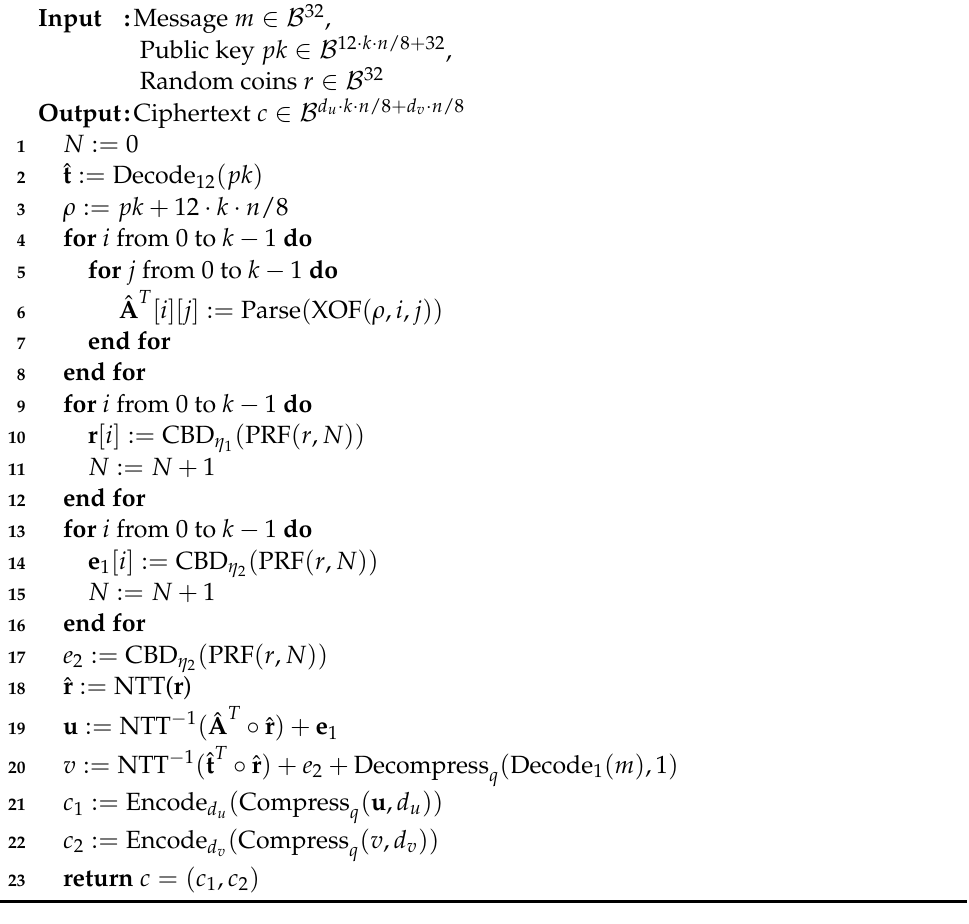
Algorithm 2: Kyber PKE encryption algorithm (Kyber.CPAPKE.Enc( pk , m , r )) [18].